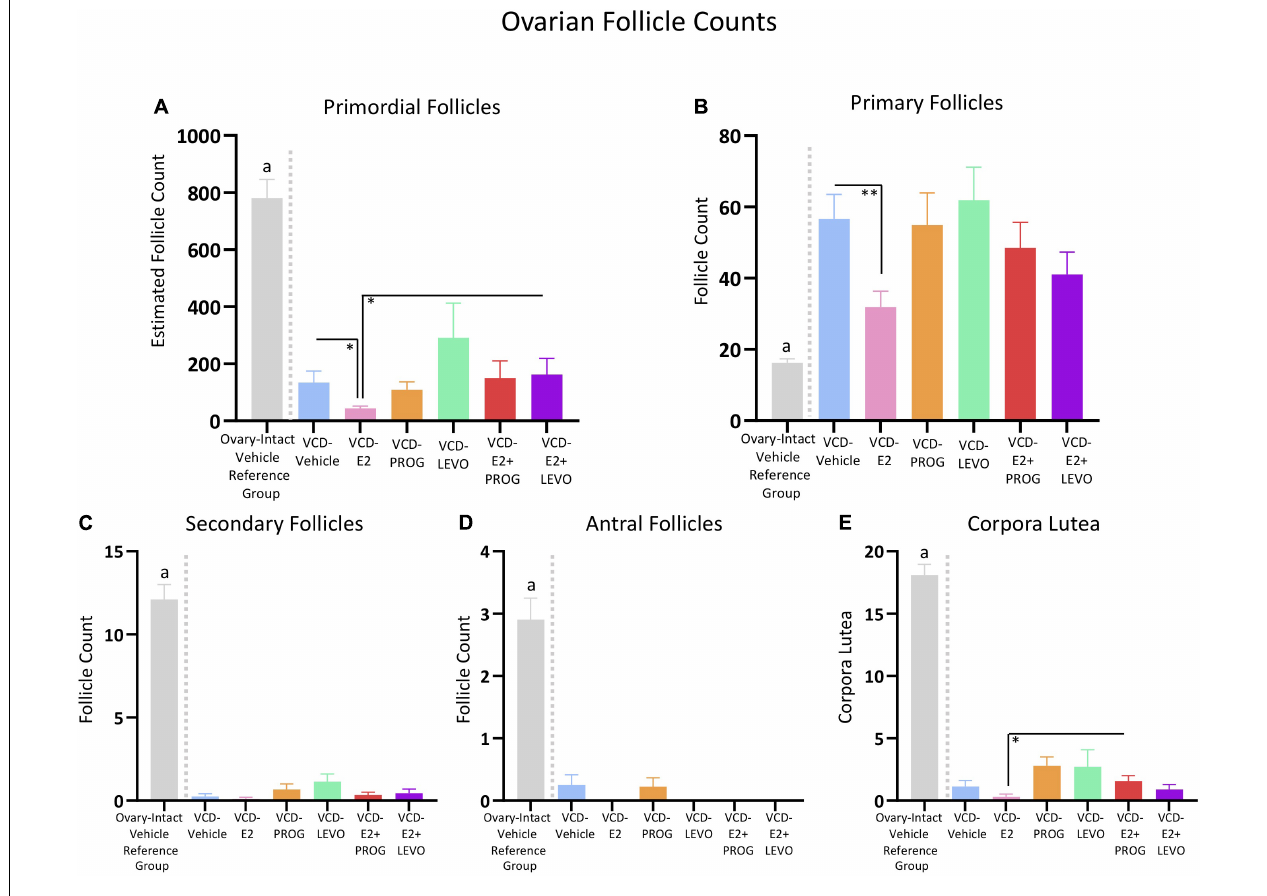
FIGURE 13 | Ovarian Follicle Counts. An independent ovary-intact reference group ( n = 10) is included to assess successful follicular depletion following VCD treatment. The letter “a” indicates that this ovary-intact reference group was significantly different from each VCD-treated group. (A) Estimated primordial follicle counts were decreased in the VCD-E2 group compared to the VCD-Vehicle group and the VCD-E2 + LEVO group. (B) Primary follicles were decreased in the VCD-E2 group compared to the VCD-Vehicle group, replicating prior work. (C) Secondary follicle counts were significantly depleted in VCD-treated groups, indicating successful accelerated follicular atresia. (D) Antral follicle counts were significantly depleted in VCD-treated groups, indicating successful accelerated follicular atresia. (E) The VCD-E2 + PROG group had more corpora lutea compared to the VCD-E2 group, suggesting occasional ovulatory cycles in this group during the transition to reproductive senescence. Significance: ∗ = p < 0.05, ∗∗ = p <